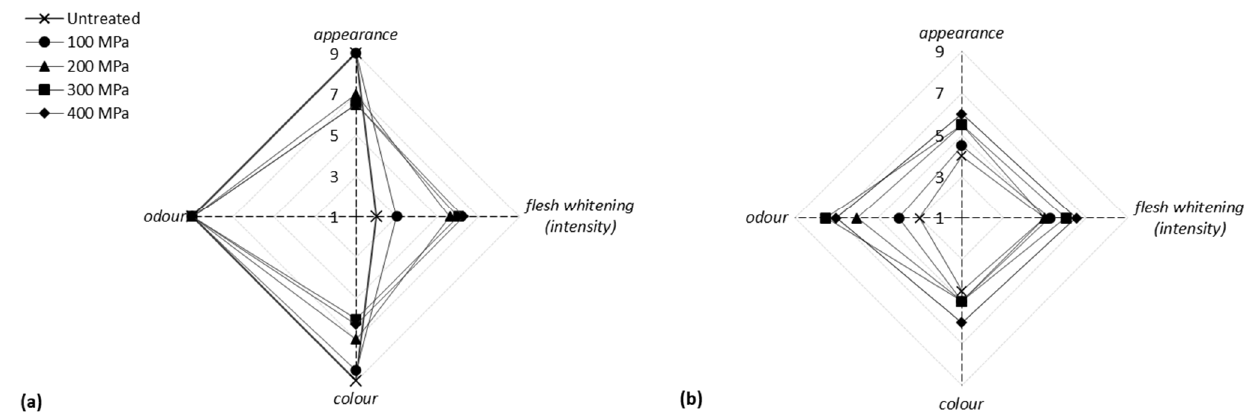
Figure 5. Radar charts of sensorial attributes of raw sea bass fillets ( a ) at day 0 and ( b ) at the end of